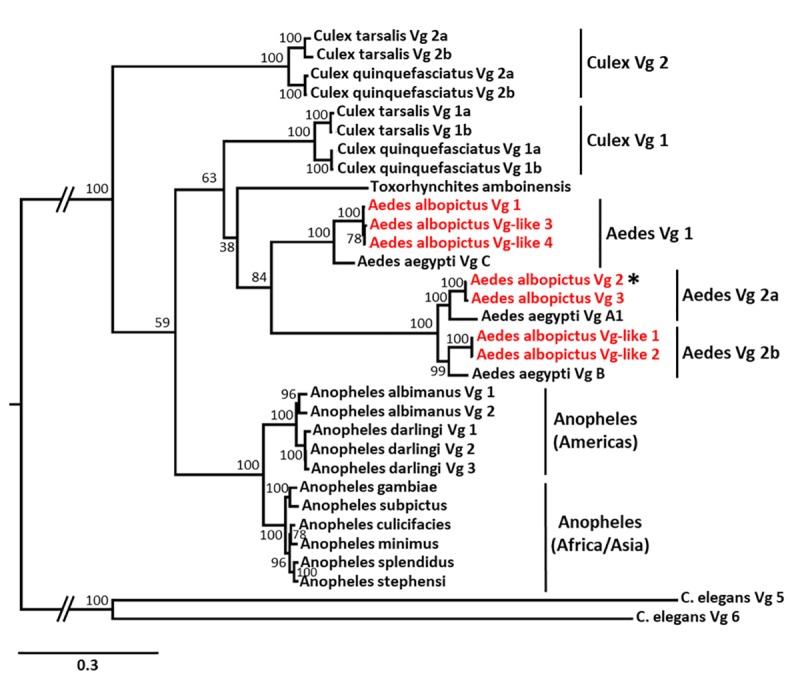
Phylogenetic relationships of mosquito vitellogenins.Maximum-likelihood phylogeny based on 30 amino-acid sequences from 13 mosquito species (see S4 Table for accession numbers). Vitellogenin genes from the nematode Caenorhabditis elegans were used as outgroup. Culex spp. have 4 copies organised in 2 clusters (Vg 1 and Vg 2), while vitellogenins from Anopheles spp. clustered based on the geographic distribution of the species. Ae. albopictus vitellogenins (in red) formed 3 clusters, closely related to the 3 vitellogenin genes of Ae. aegypti. Notably, several genes currently annotated as ‘Vitellogenin-A1–like’ are clearly true vitellogenins. The differentially expressed gene used in the knockdown experiment is indicated by an asterisk. 1,000 bootstraps were performed for branch support. Vg, vitellogenin.